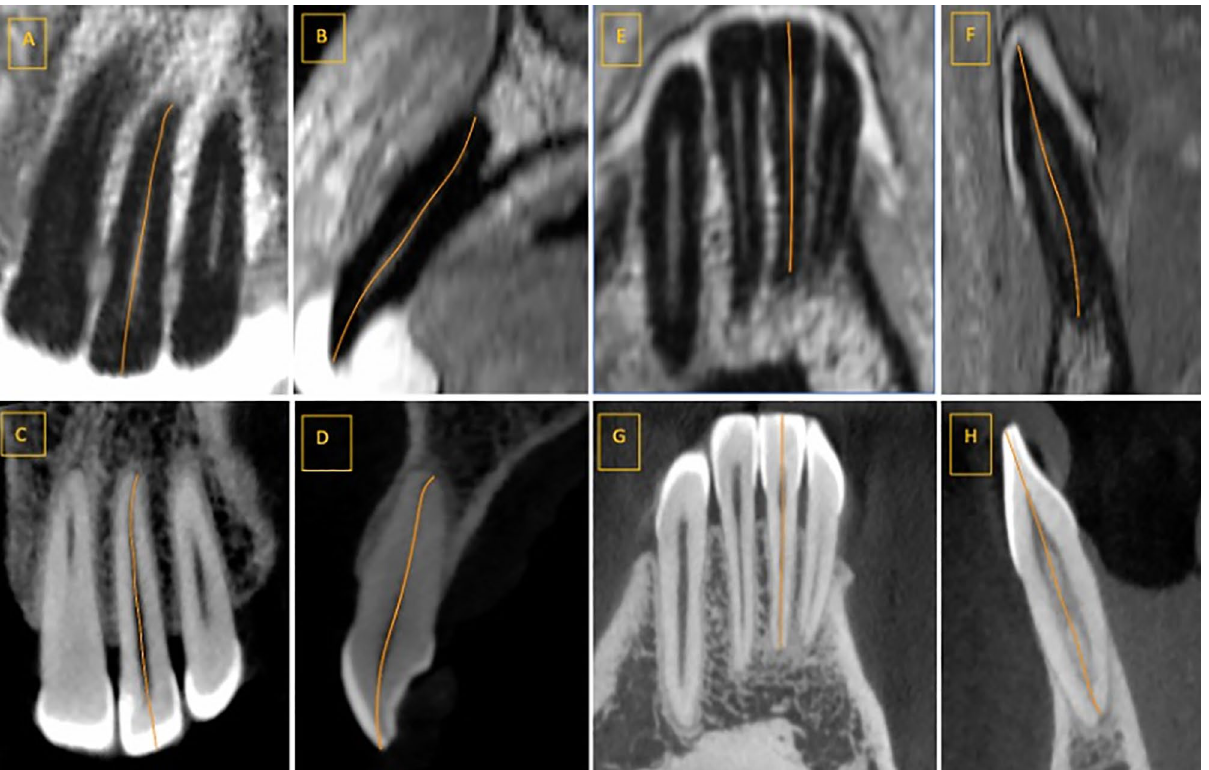
Figure 1. Canal length measurements by dMRI (upper row) and CBCT (lower row) in the mesio-distal (M-D) and vestibulo-oral (V-O) directions in the second left upper incisor ( A–D ) and the first right lower incisor ( E–H ). dMRI slices of a second incisor in the left upper jaw in the M-D direction ( A ) and the V-O direction ( B ). ( C,D ) Are the corresponding CBCT slices. dMRI slices of a first incisor in the right lower jaw in the M-D direction ( E ) and the V-O direction ( F ). ( G,H ) Are the corresponding CBCT slices.